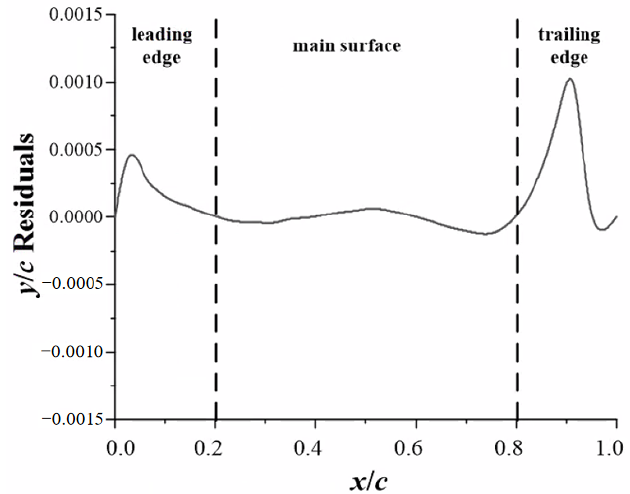
Figure 8. Analysis of arc fitting error in blade.